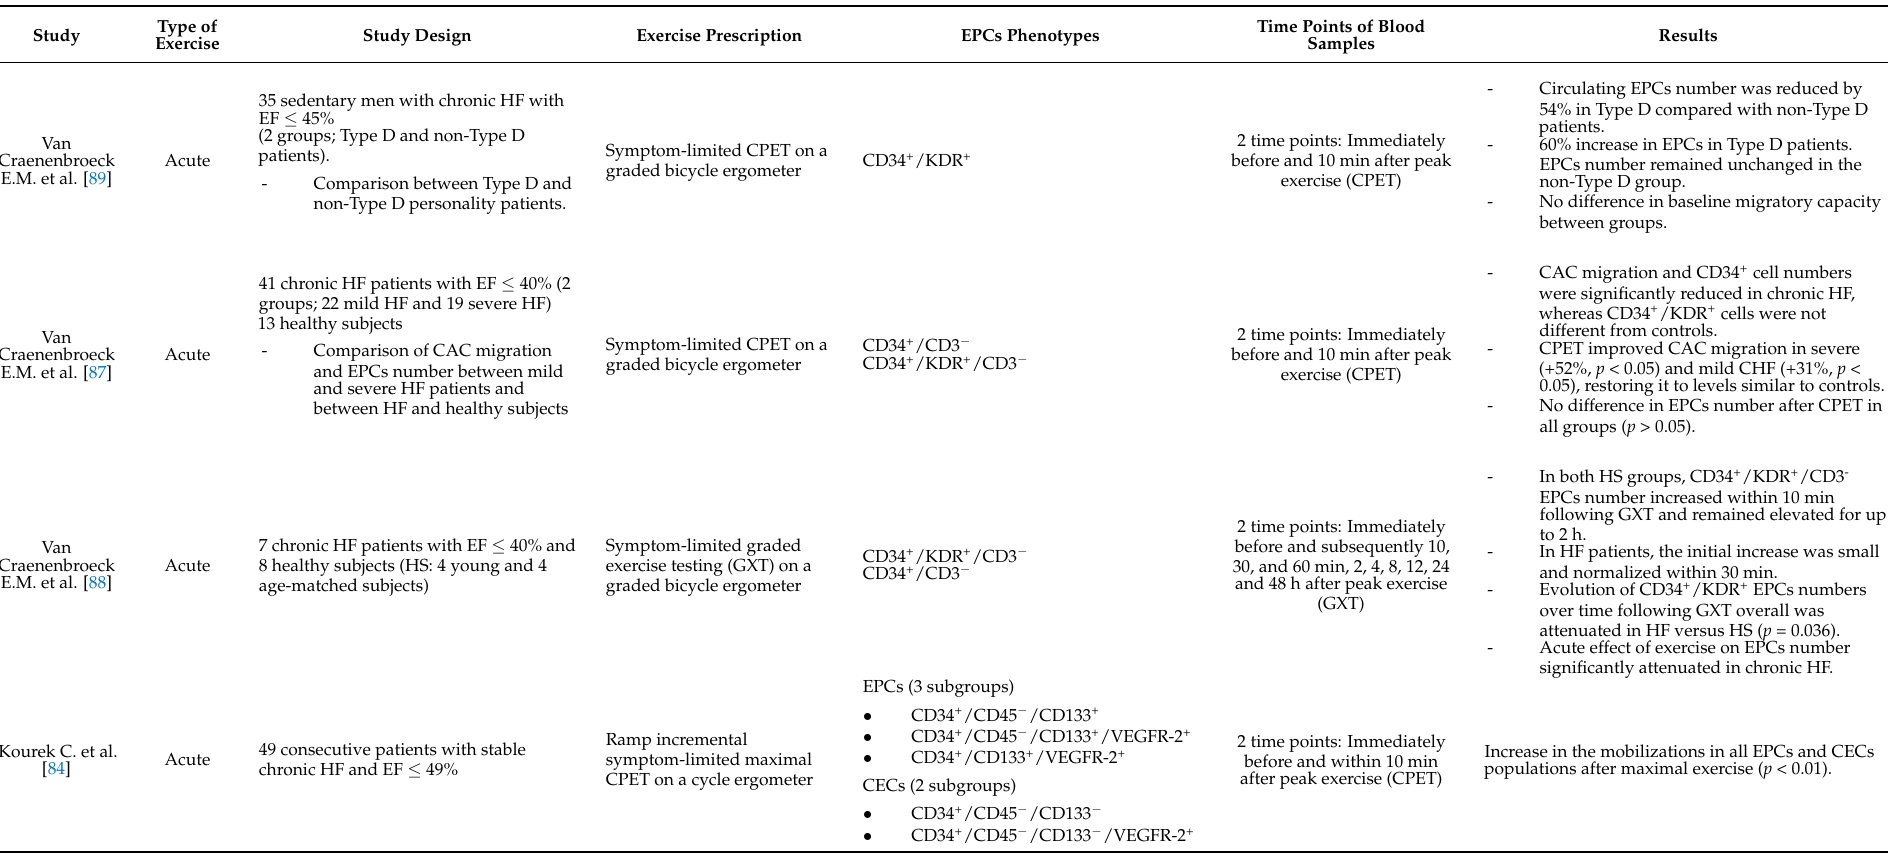
Table 2. Studies investigating the acute and long-term effects of exercise on EPCs and CECs in patients with chronic